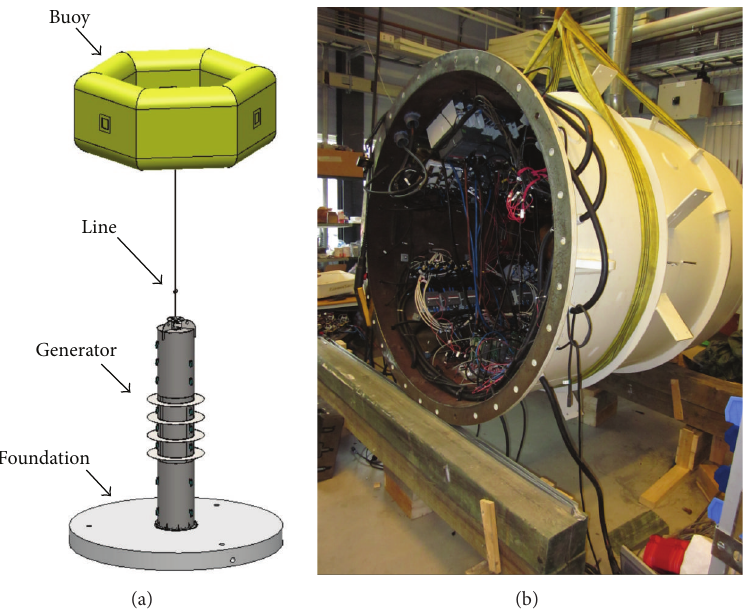
Figure 1: (a) Schematic view of the wave energy converter. The linear generator is put on the seabed and is connected with the buoy through the line. (b) Offshore marine substation for connection of multiple WECs to the onshore electric grid.